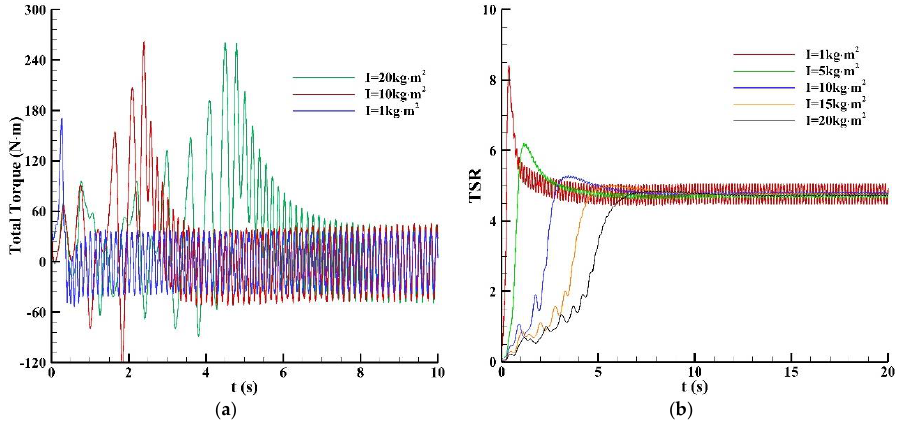
Figure 7. Effects of the moment of inertia on the hydrodynamic performance (No-load condition): ( a ) Torque; ( b ) TSR. Table 2. Calculating parameters for different generators.